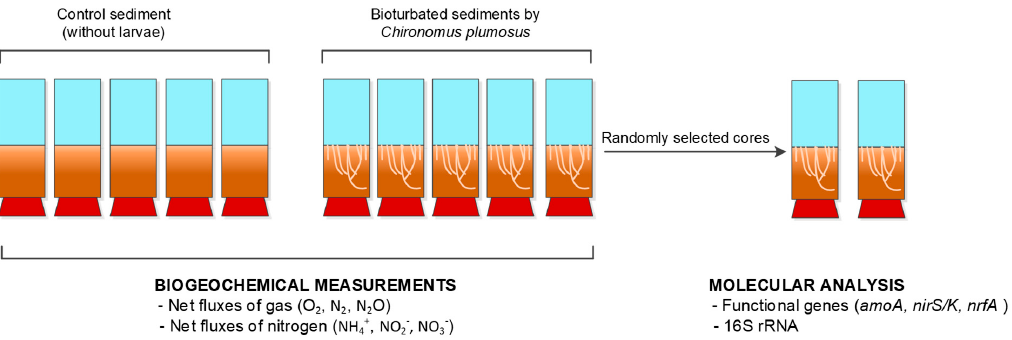
Figure 1. Scheme of the experimental set up.